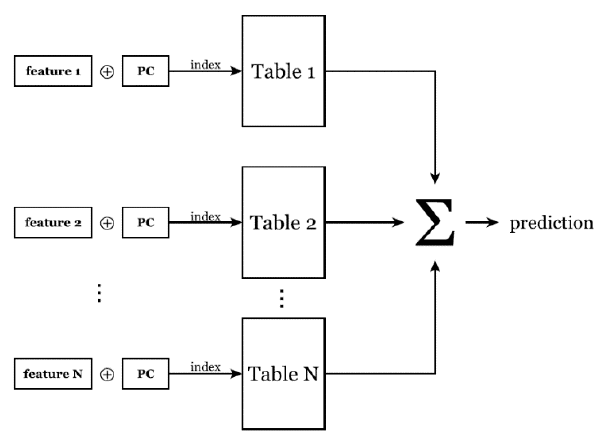
Figure 9. Perceptron Reuse Predictor [12]: After XORing the PC and each feature and adding all indexed weights, the predictor predicts the reusability of the block based on the added weights.